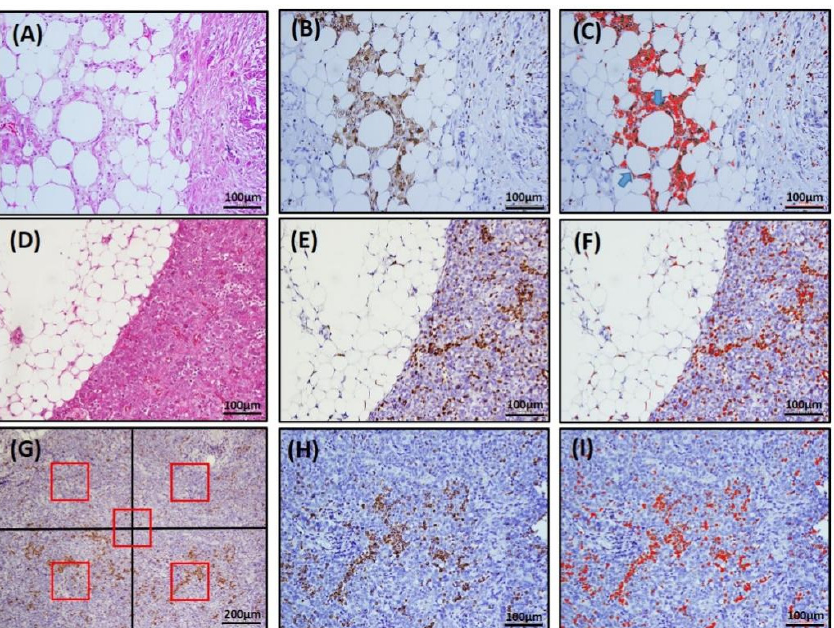
Figure 1. Representative image of CLS and TAMs by immunohistochemical staining for CD68 and ImageJ software-assisted images. ( A , D , G ), H&E staining; ( B , E , H ), IHC CD68 staining; ( C , F , I ), ImageJ images. In ( C ), note that there are two adipocytes completely surrounded by CD68-positive macrophages (arrows), counted as two CD68 + CLSs. ( G ) For TAM density, the area with the greatest concentration of CD68-stained TAMs was identified. Then, five fields (red box, four quadrants and a central area, each field contained 0.04 mm 2 ) under 100 × magnification were selected, and the number of CD68 + macrophages was counted under 200 × magnification with the assistance of ImageJ software ( I ).